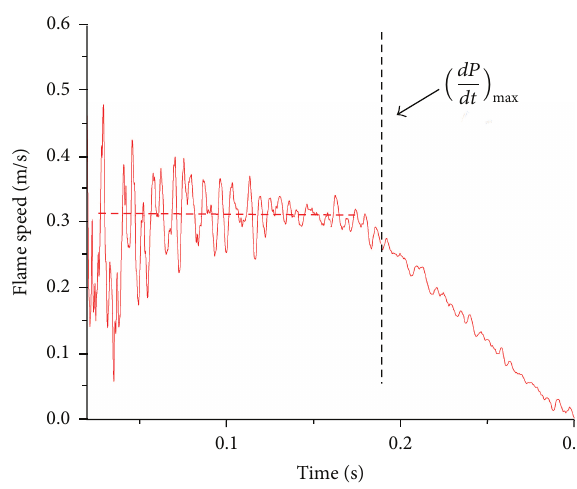
Figure 7: Calculate flame speed from pressure-time